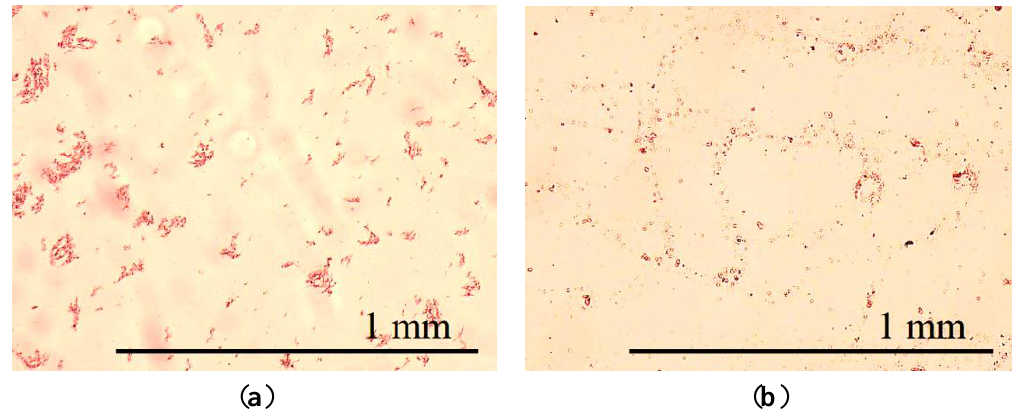
Figure 3. Bright-field micrographs of ferronematics based on ( a ) 4-cyano-4′-heptyloxybiphenyl (7OCB) and ( b ) paramagnetic liquid crystalline (PLC) material 1 at 120 °C where they exhibit isotropic phase ( ϕ = 1 × 10 −3